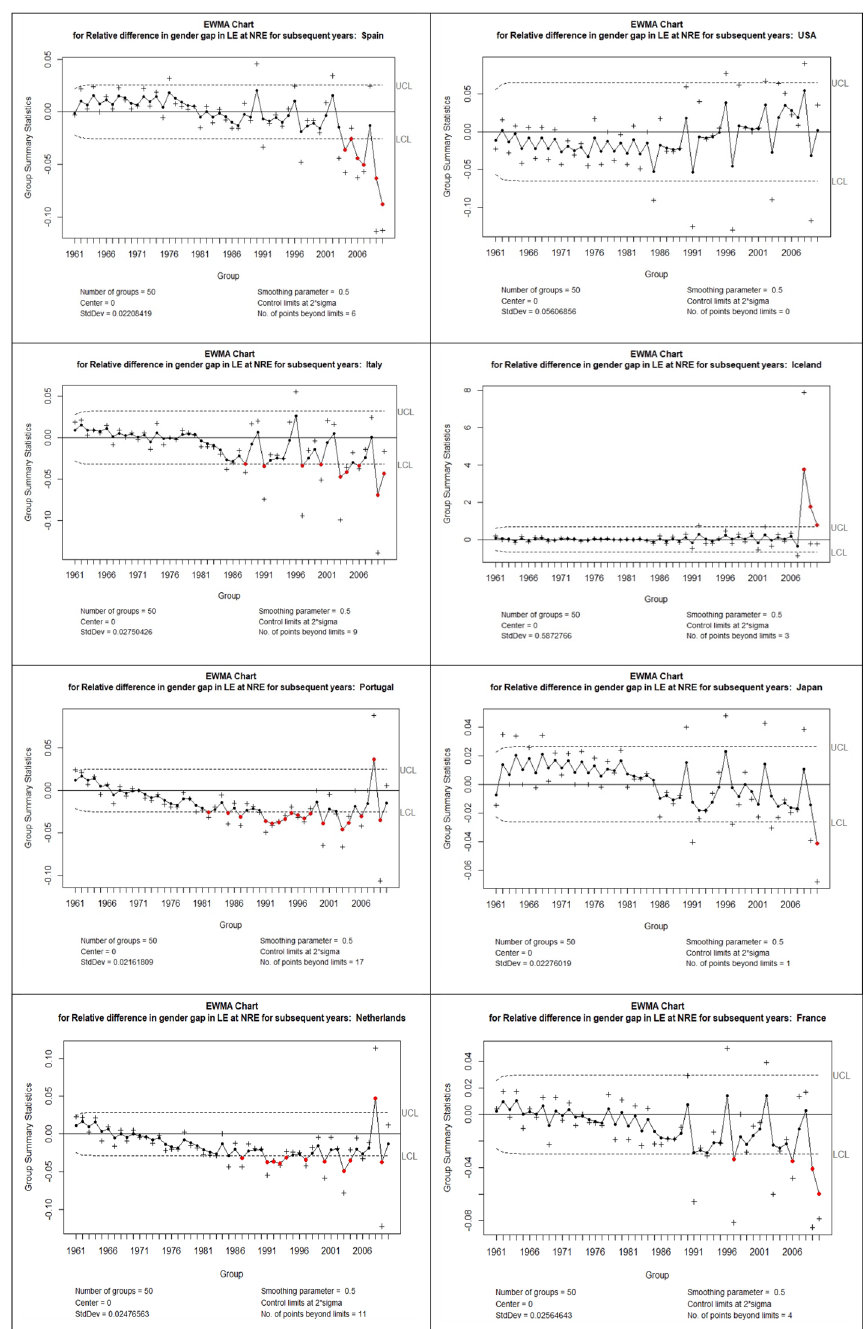
Fig. 1 EWMA charts for relative variation of the gender gap in LE at NRA over cohorts calculated according to projection derived from the model-assembling (MA)